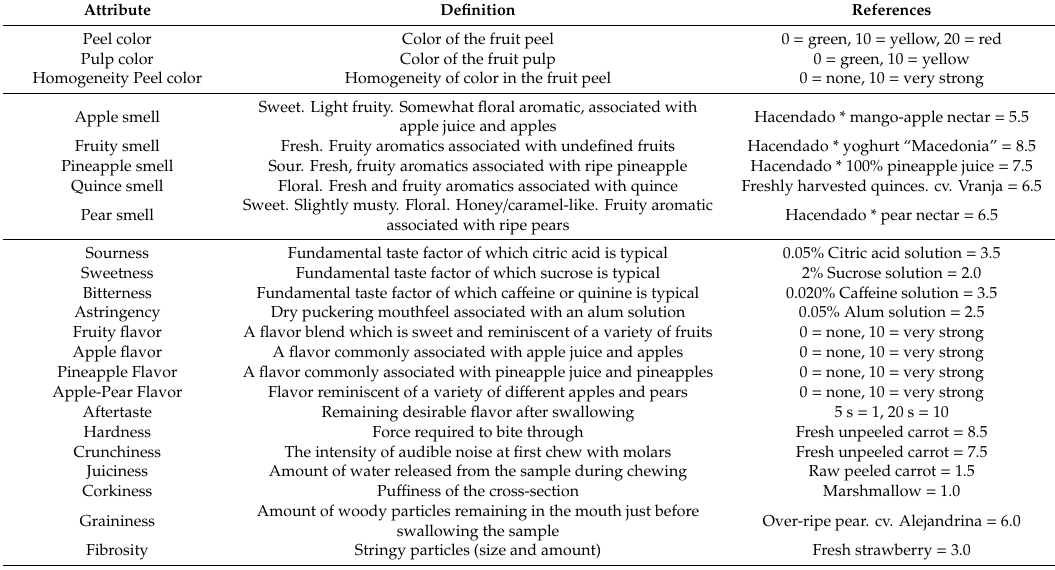
List of appearance, flavor, and texture attributes used to describe apple fruits and their